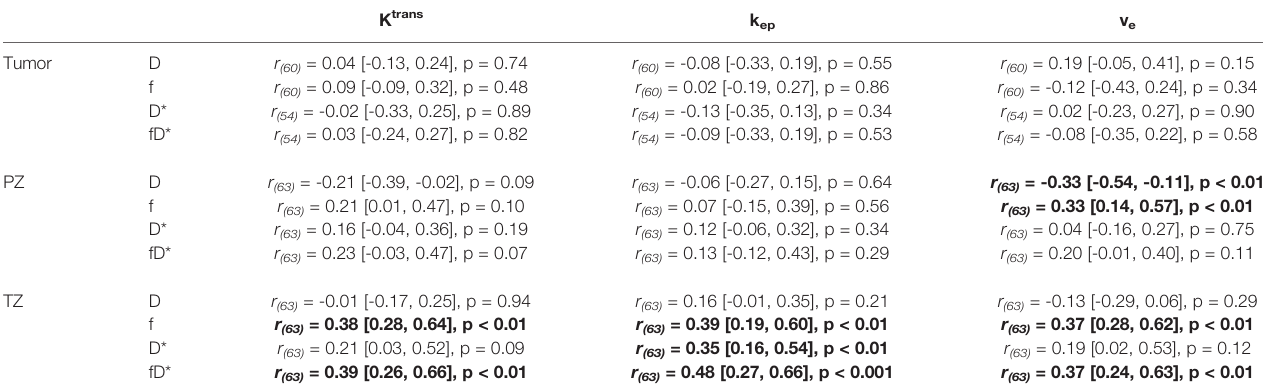
TABLE 4 | Repeated measures correlations between IVIM and DCE parameters, separately presented for each